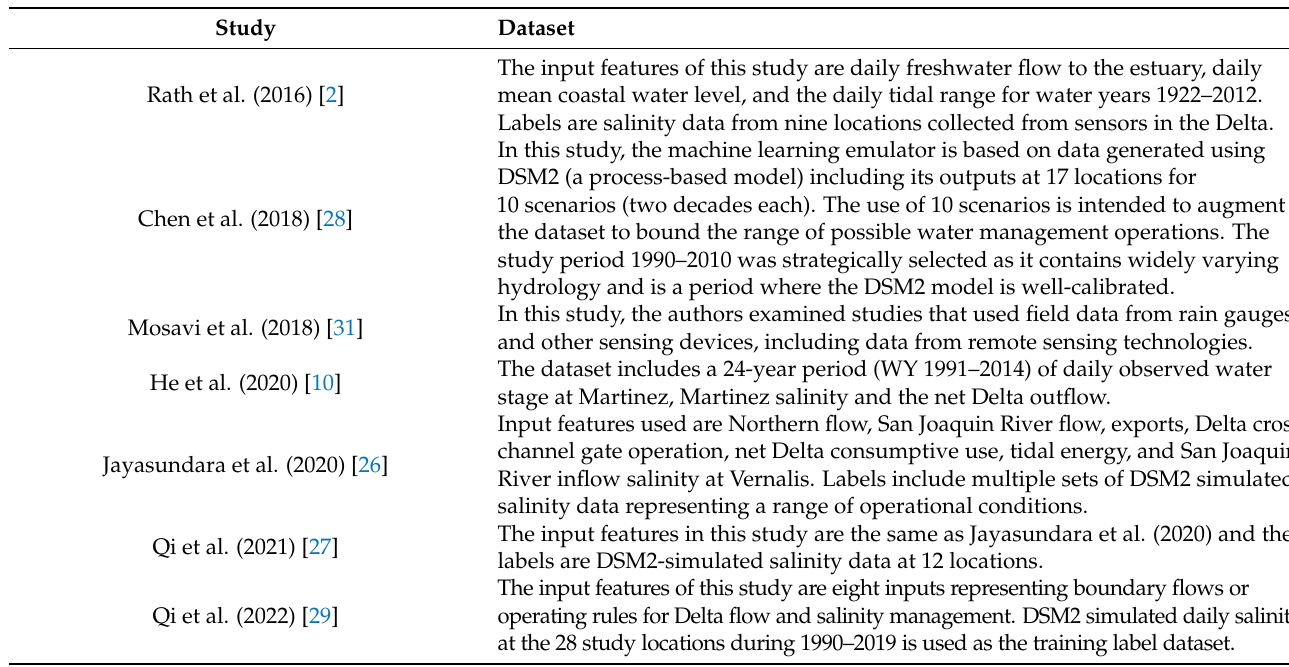
Table A1. Datasets applied in relevant previous studies.